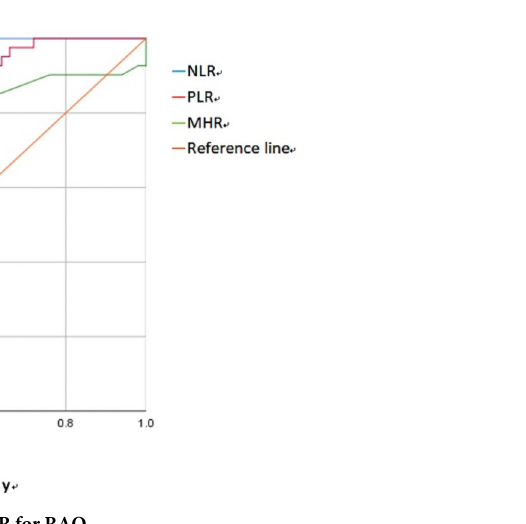
Fig 1. ROC analysis of NLR, PLR and MHR for RAO.